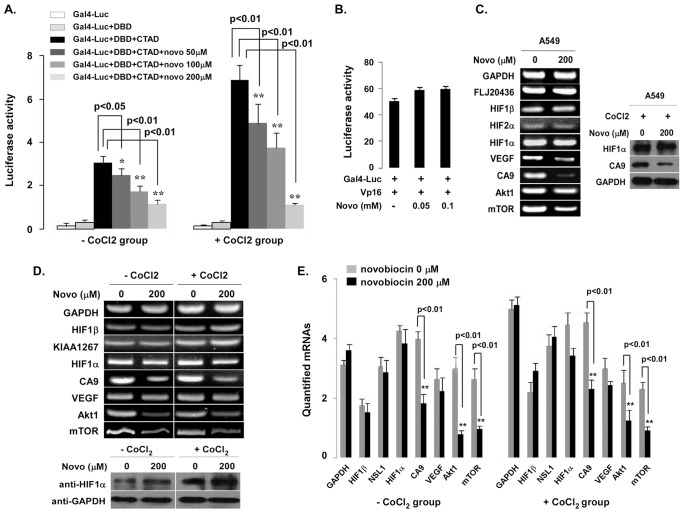
Novobiocin represses the transcriptional activity of HIF1α CTAD and down regulates HIF1α target genes.
A. Novobiocin inhibits the activation of GAL4-dependent luciferase reporter in 293T cells. 293T cells were co-transfected with luciferase reporter carrying GAL4-Luc and a Renilla luciferase plasmid (HIF1α DBD and HIF1α CTAD). After 24 hours transfection, cells were treated with 50, 100, and 200 µM novobiocin with or without CoCl2. After 48 hours transfection, dual luciferase activities were measured and firefly values were normalized with Renilla values. B. 293T cells were co-transfected with GAL4-Luc and VP16 plasmid. After 24 hours transfection, cells were treated with 50 and 100 µM novobiocin. C. Novobiocin down-regulates HIF1α target genes. A549 cells were cultured with or without 200 µM novobiocin for 24 hours in the presence or absence of CoCl2 (150 µM). Selective HIF1α target or non-target gene expressions were measured by RT-PCR (left panel). Western blot analysis was performed with indicated antibodies (right panel). D. Novobiocin affects mTOR gene expression in MCF-7 cells. MCF-7 cells were treated with 200 µM novobiocin in the presence or absence of CoCl2 (150 µM). Indicated gene expressions including Akt1and mTOR were measured by RT-PCR (upper panel). HIF1α protein is shown in the lower panel. E. mRNA was quantified by densitometry using Quantity One software (BioRad) (right panel). Error bars represent the standard error of the mean of 2∼3 independent experiments. The Student’s t-test was performed to compare difference between with or without novobiocin treatment (significance: *p<0.05 and **p<0.01).